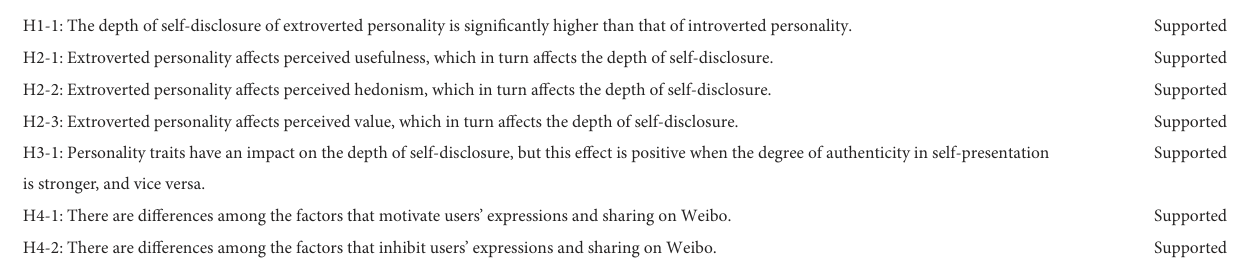
TABLE 11 Test results of